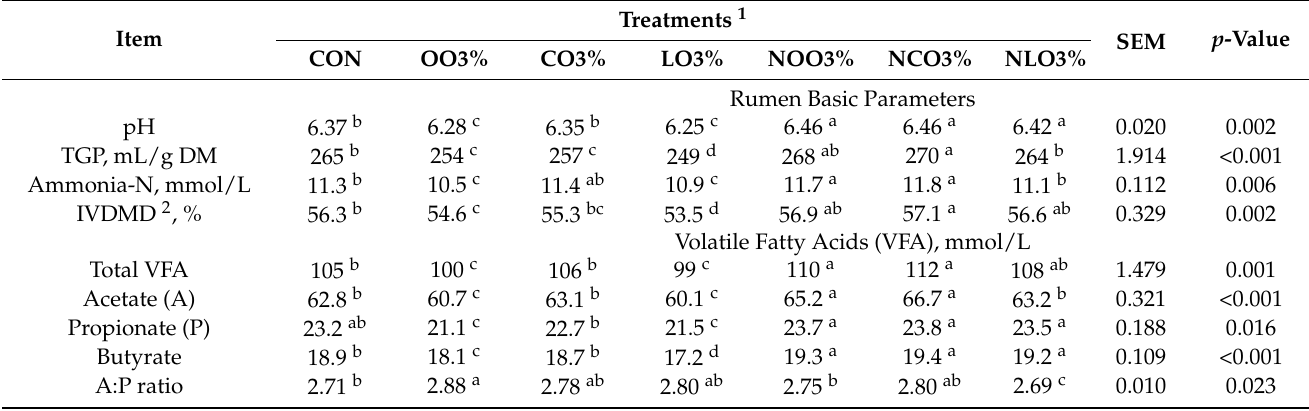
Table 7. Effect of the supplementation of raw and nanoemulsified olive oil, corn oil, and linseed oil on basic rumen parameters, volatile fatty acid, and fatty acid